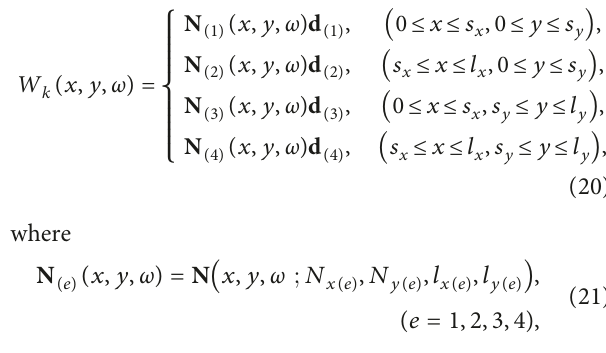
the node at which the stationary (cid:31) the nodes on the boundary edges, and (cid:31) ◇